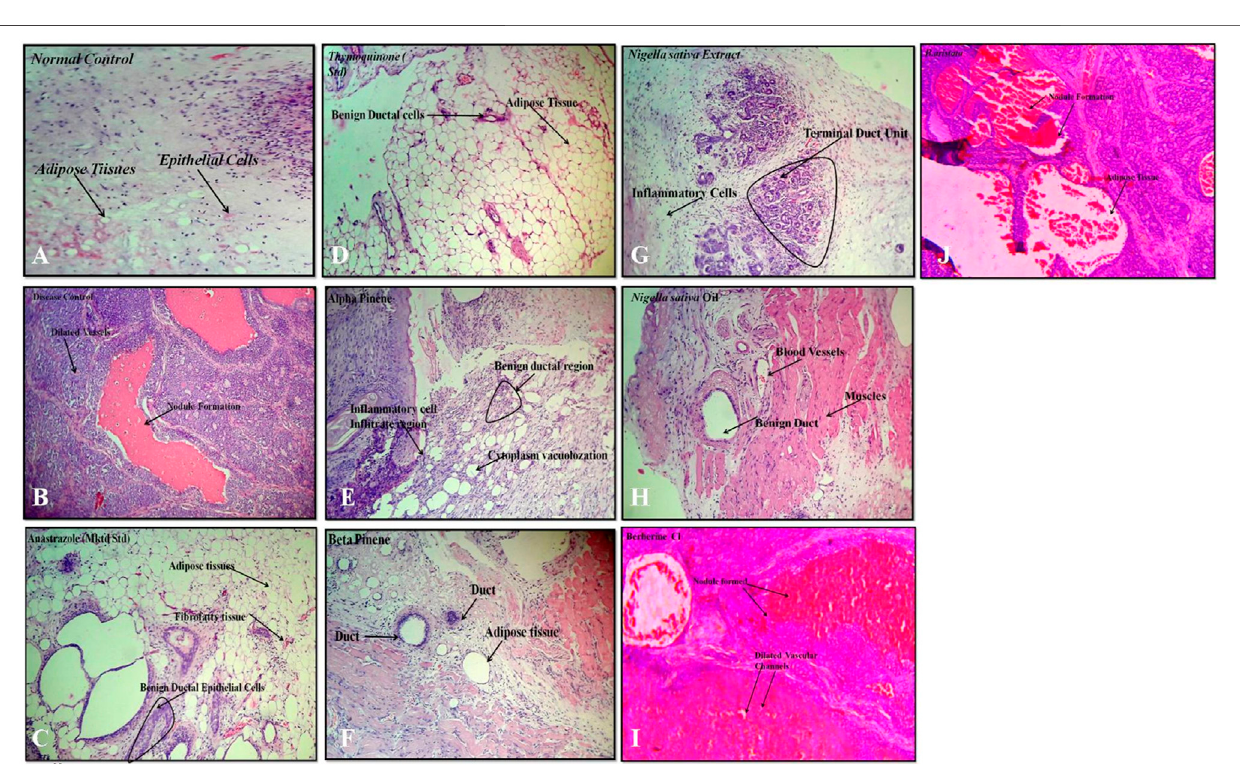
FIGURE7| Histopathology: (A) normalcontrol, (B) diseasecontrol, (C) marketedstandard, (D) thymoquinoneStd, (E) α -pineneStd, (F) β -pineneStd, (G) N.sativa extract, (H) N. sativa oil, (I) berberine Cl std, and (J) Berberis aristata extract.